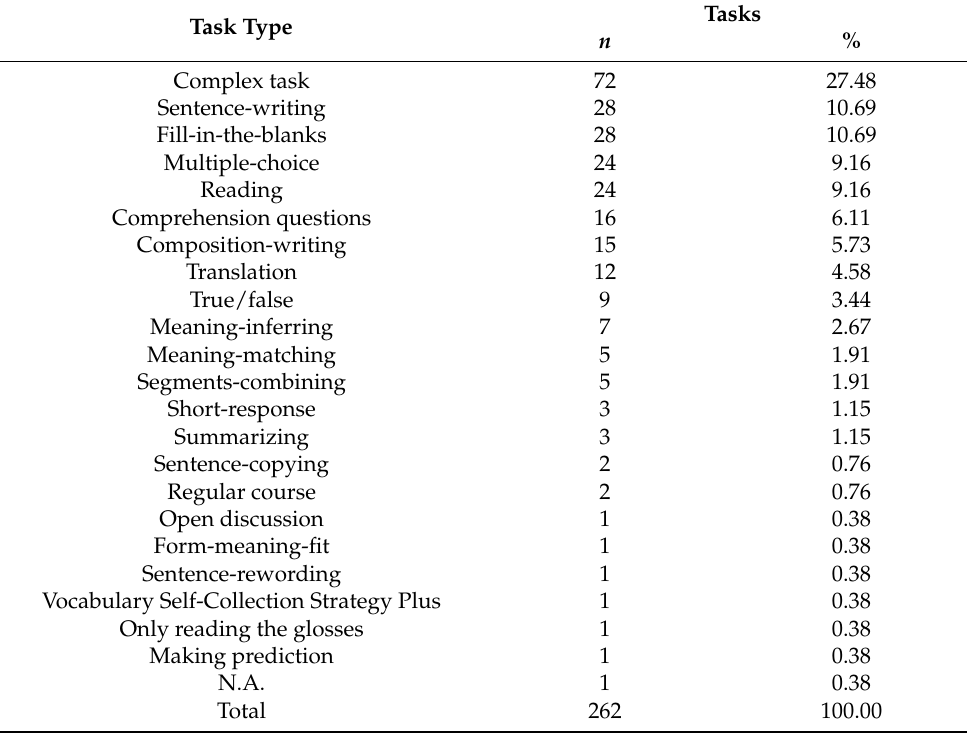
Table 2. Prevalence of task